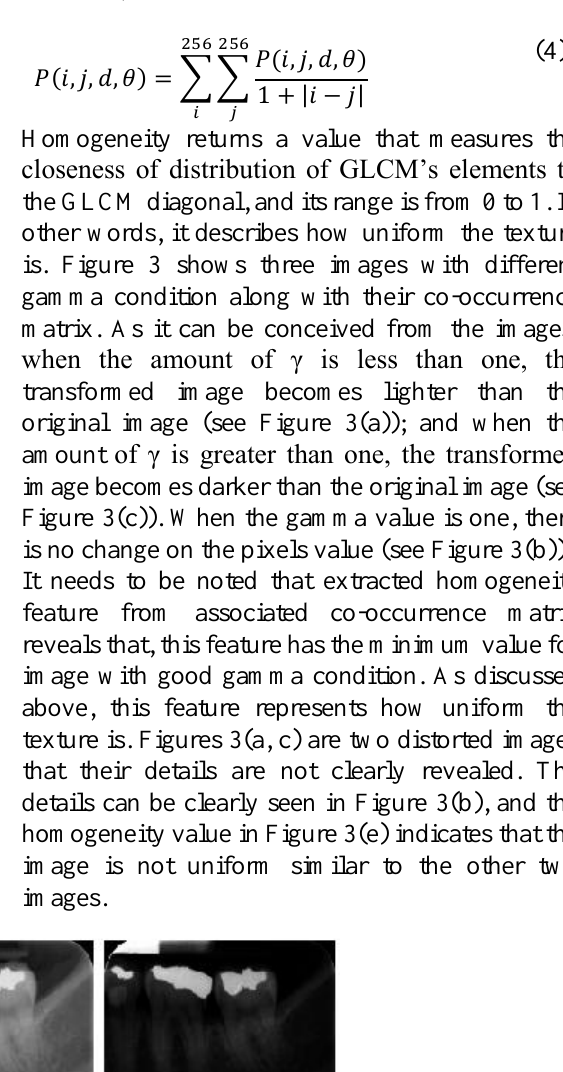
Figure 2. Comparison between gamma correction and histogram equalization in enhancing the panoramic radiograph shown in Figure